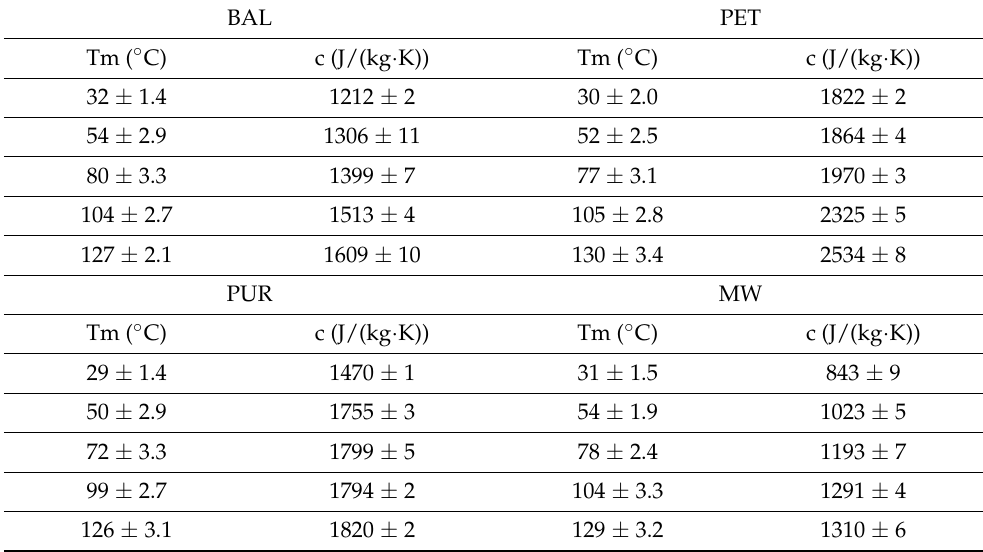
Table 6. Results of the specific heat (J/(kg · K)) using the indirect methodology (the mean and the standard deviation of three test